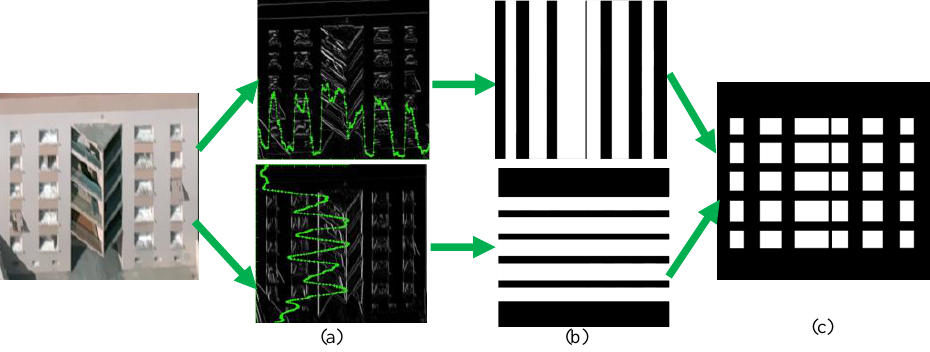
Figure 8: Mask of opening hypotheses. (a) Horizontal gradients are accumulated vertically and vertical gradients are accumulated horizontally. (b) Local accumulation peaks are used to create masks of rows and columns. (c) The masks are multiplied to obtain the final mask of opening hypotheses.